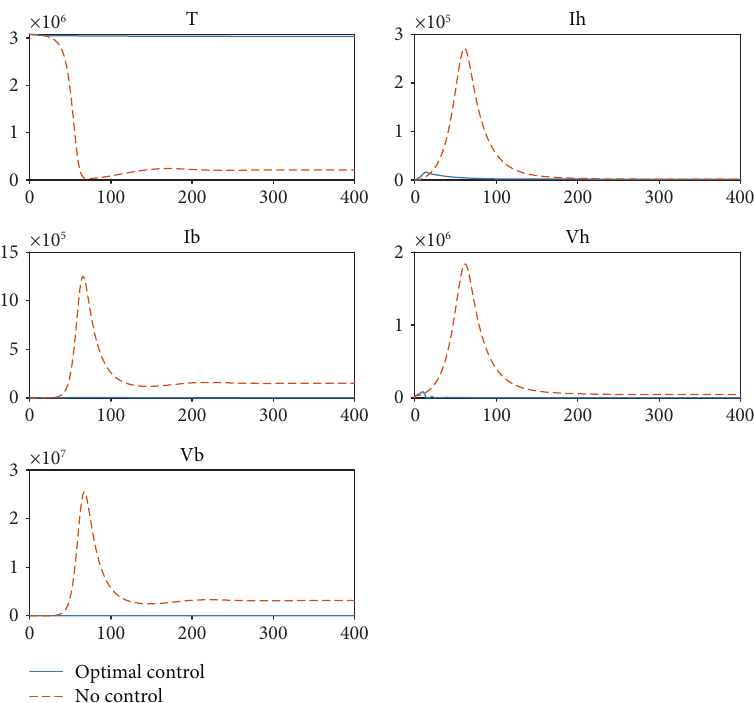
Figure 6: Dynamics of delayed HIV/HBV model with and without control. Parameter values are as shown in Table 1. Horizontal axes represent time in days.